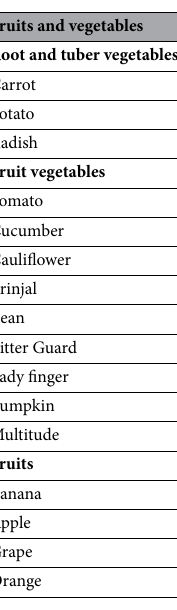
Table 1. Mean concentrations of nitrate in the tested fruits and vegetables.